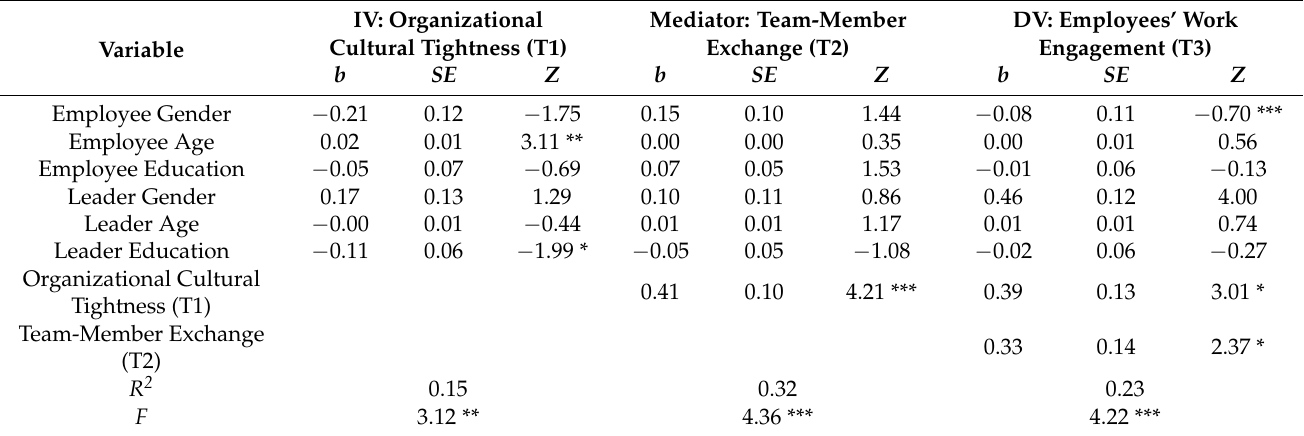
Table 2. Model’s Regression Path and Mediation Effect Analysis.